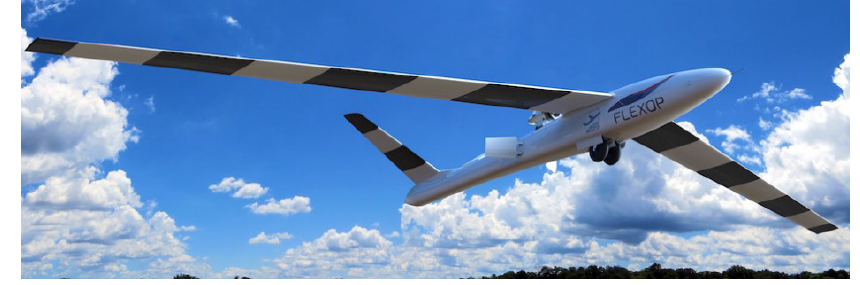
Figure 1. FLEXOP flutter